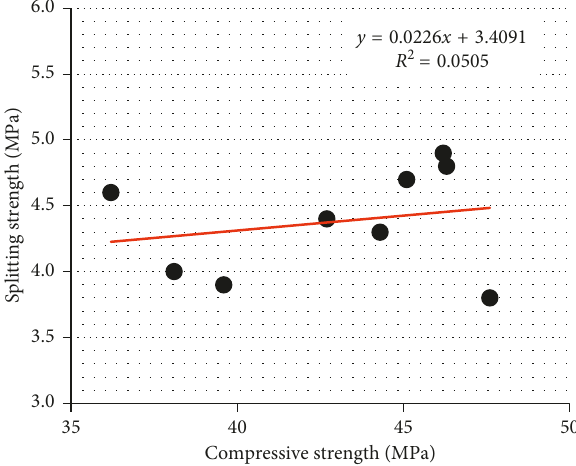
Figure 18: Correlation between compressive and splitting